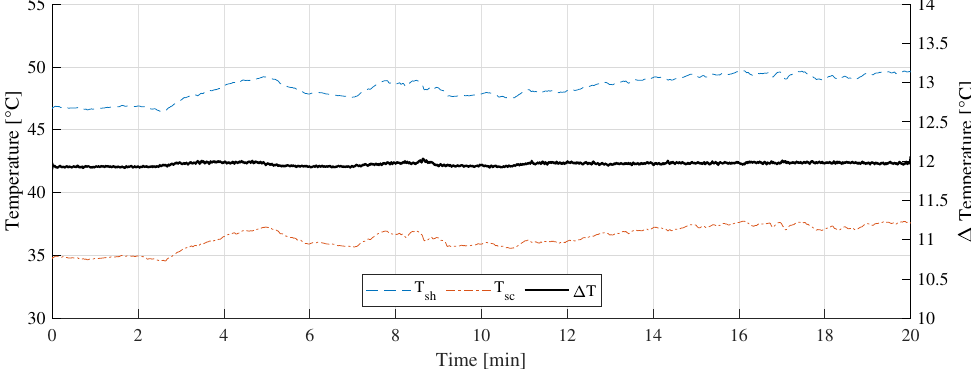
Figure 19. Temperature measurement during the C